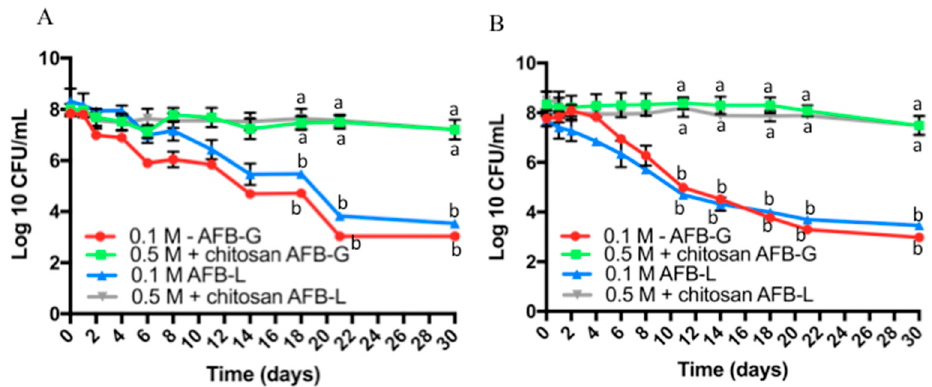
Figure 2. Probiotic viability over time. Microbial concentration measured for 30 days for the freeze-dried capsules ( A ) and for the thermal-dried capsules ( B ). For both cases, two parameters were studied: the broth used (AFB-G or AFB-L) and the capsule structure (if crosslinked in 0.1 M CaCl 2 for 10 min or in 0.5 M CaCl 2 for 10 min and then coated with chitosan). Bars represent standard deviation of three independent experiments. Different letters indicate significant differences ( p < 0.05).